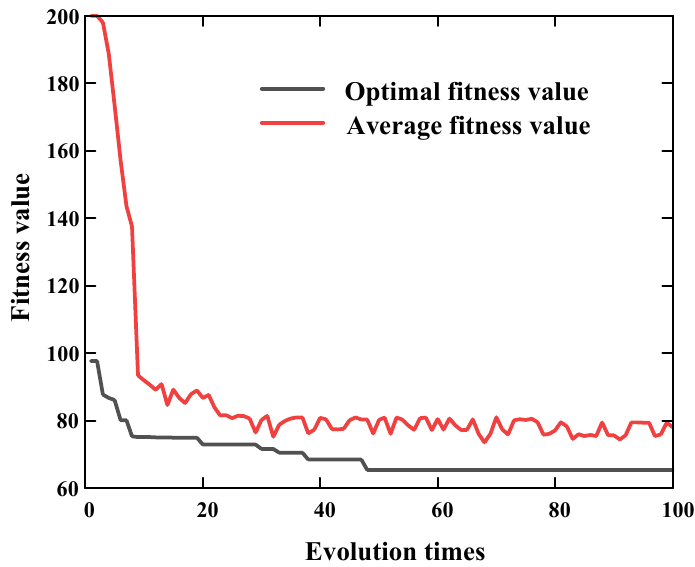
Figure 10. Optimization curve of IPSO.